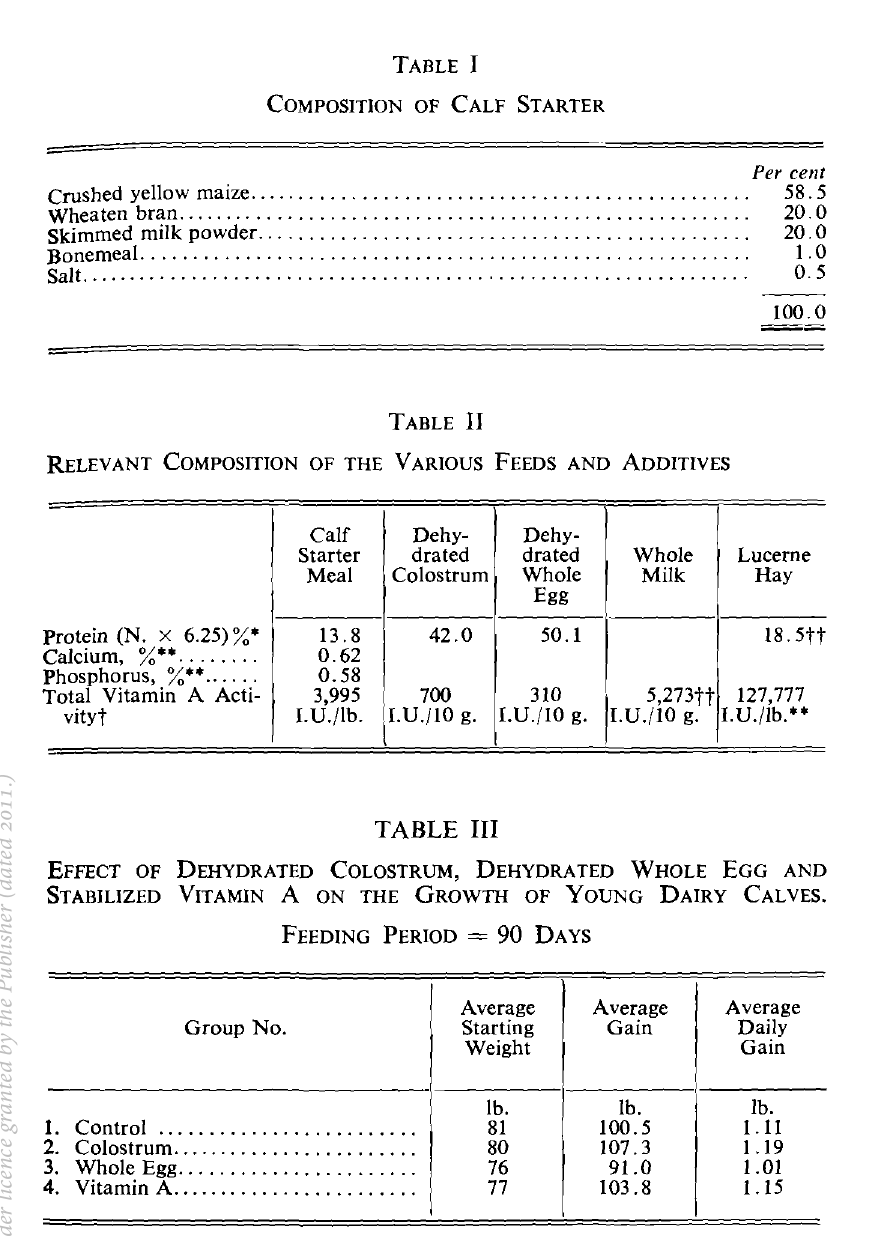
RELEVANT COMPOSITION OF THE VARIOUS FEEDS AND ADDITIVES